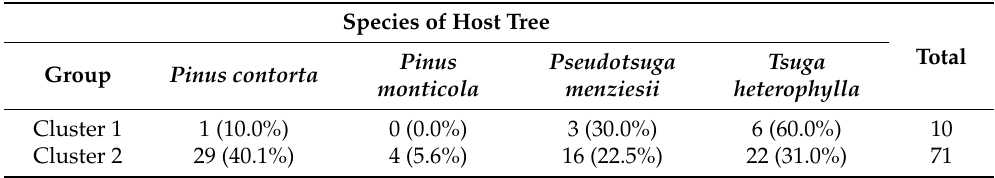
Table 3. Number and proportion (%) of S. coniferarum from each tree species in each cluster collected in Tacoma, WA, USA from 29 August–10 September